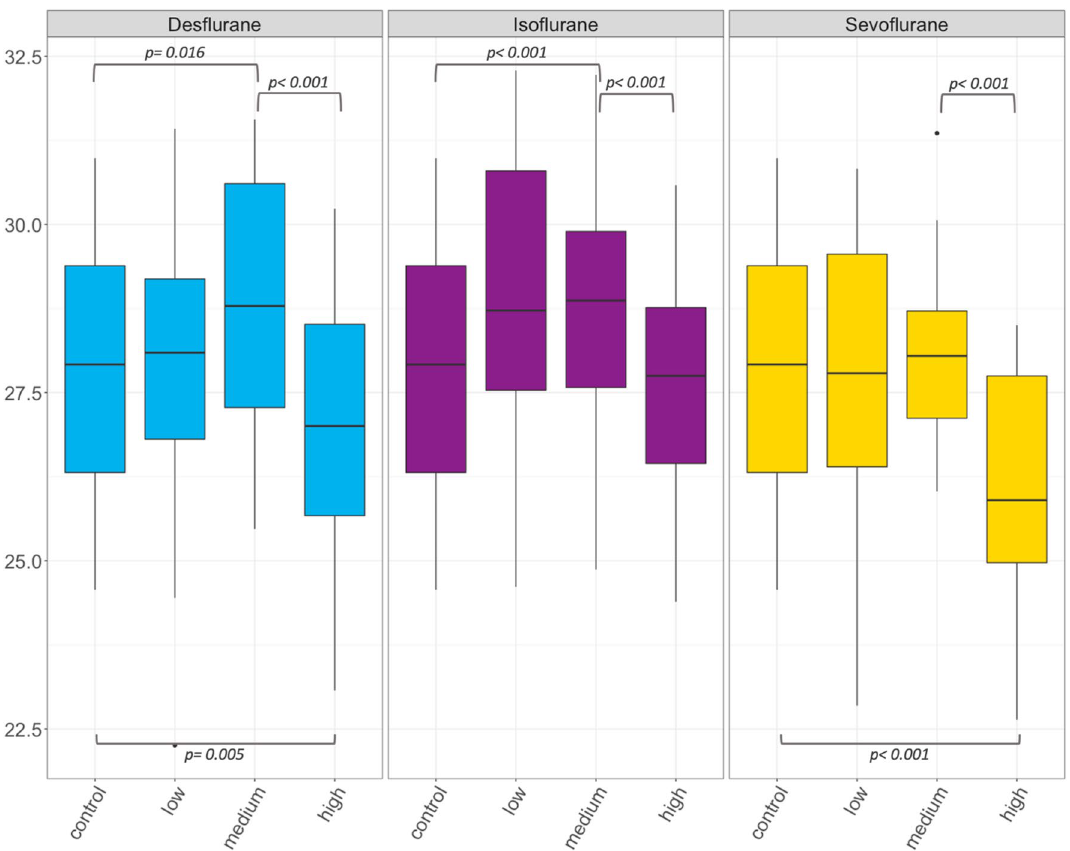
Figure 1. Box plots of p50 (in mmHg) for desflurane, isoflurane and sevoflurane at low (corresponding to MAC 0.5), medium (MAC 1.0) and high (MAC 2.0) concentration. Significant differences are indicated by brackets and p values are reported. P50 is oxygen partial pressure at 50%